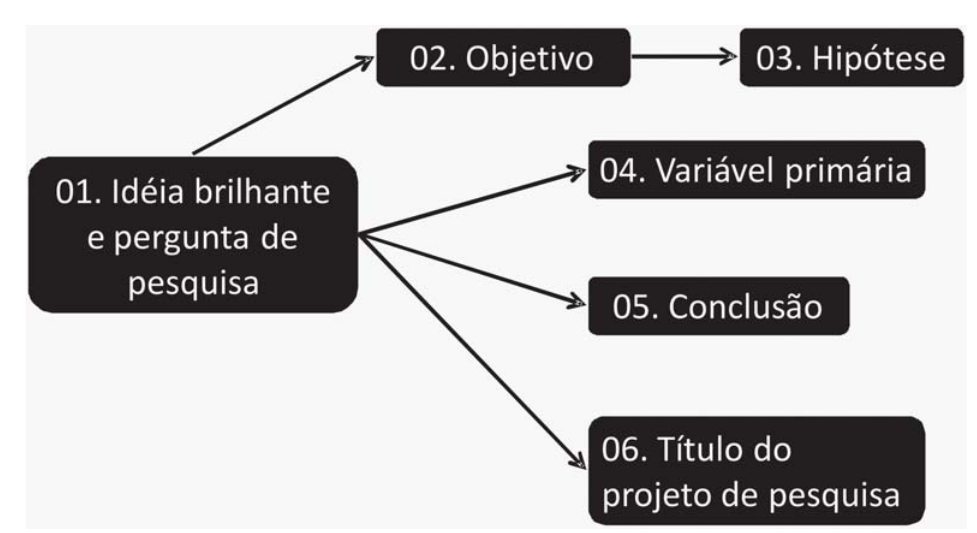
Fig. 1 - “O Sexteto Mágico da Pesquisa